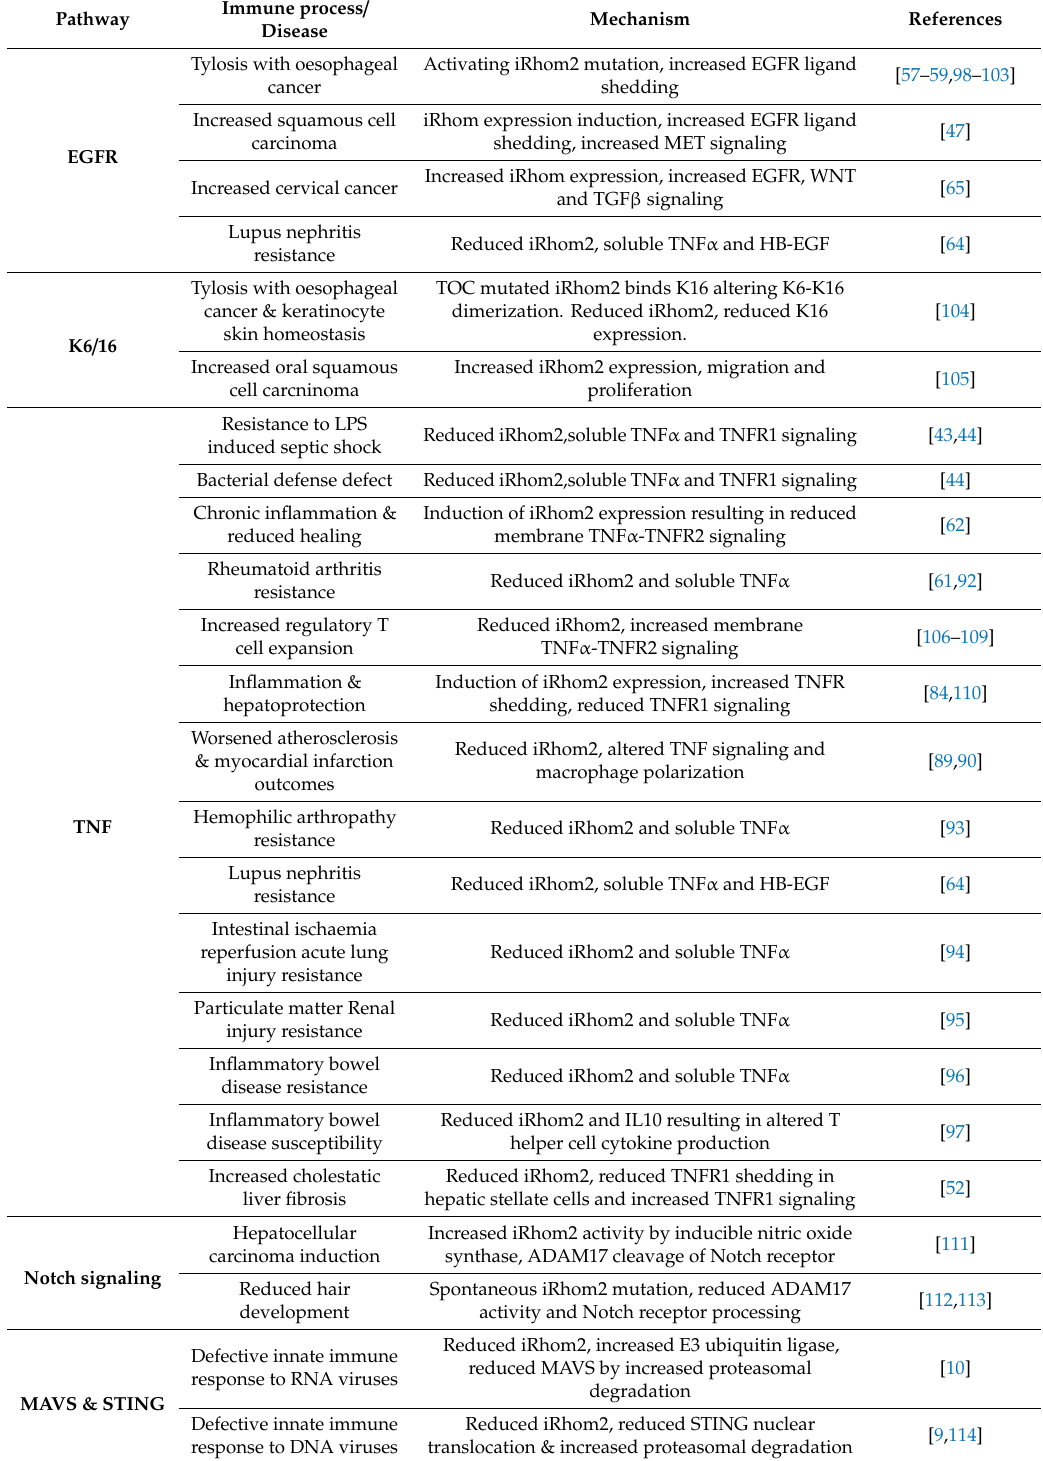
Table 1. iRhom2 regulated pathways in immunity and